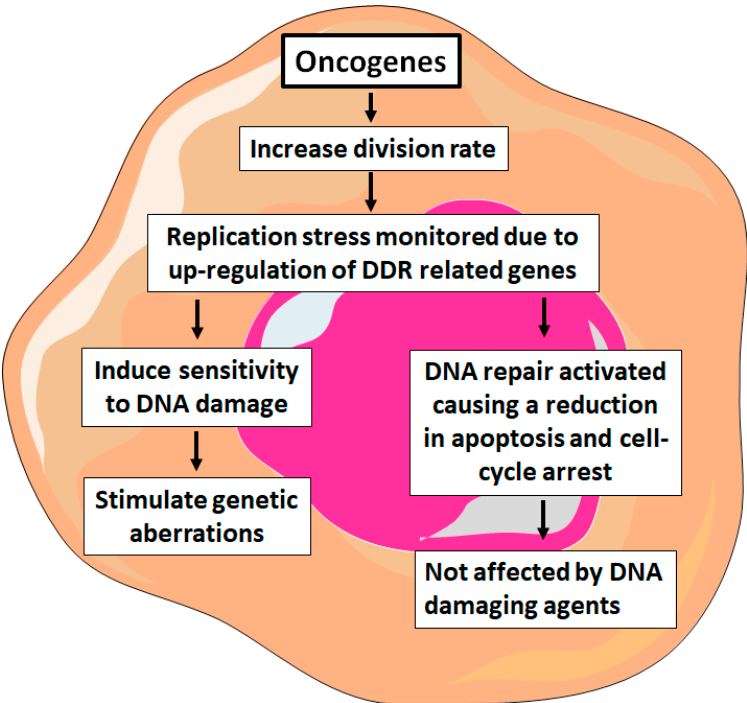
Figure 1. The DNA Damage Response (DDR) pathway in cancer cells. Several oncogenes are 249 responsible for controlling cell division rate under cellular stress in leukemic cells. 250 The ten-eleven translocation-2 ( TET2 ) gene is located on chromosome 4q24. The expression of 251